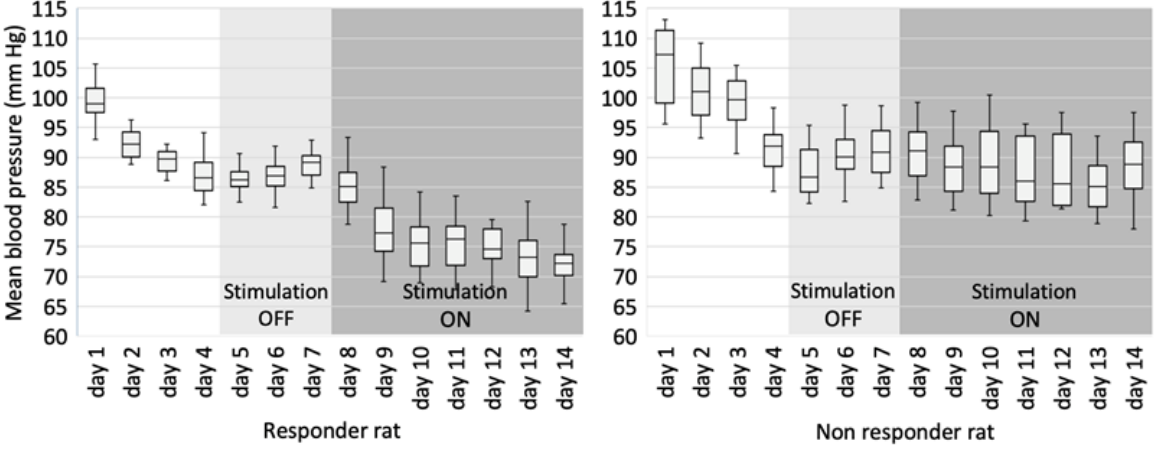
Figure 6. Typical graphs show a change in mean arterial blood pressure during two weeks of the experiment: response to stimulation on the left side and lack of response on the right side. “Stimulation OFF” and Stimulation ON” periods are shown in different shades of grey.